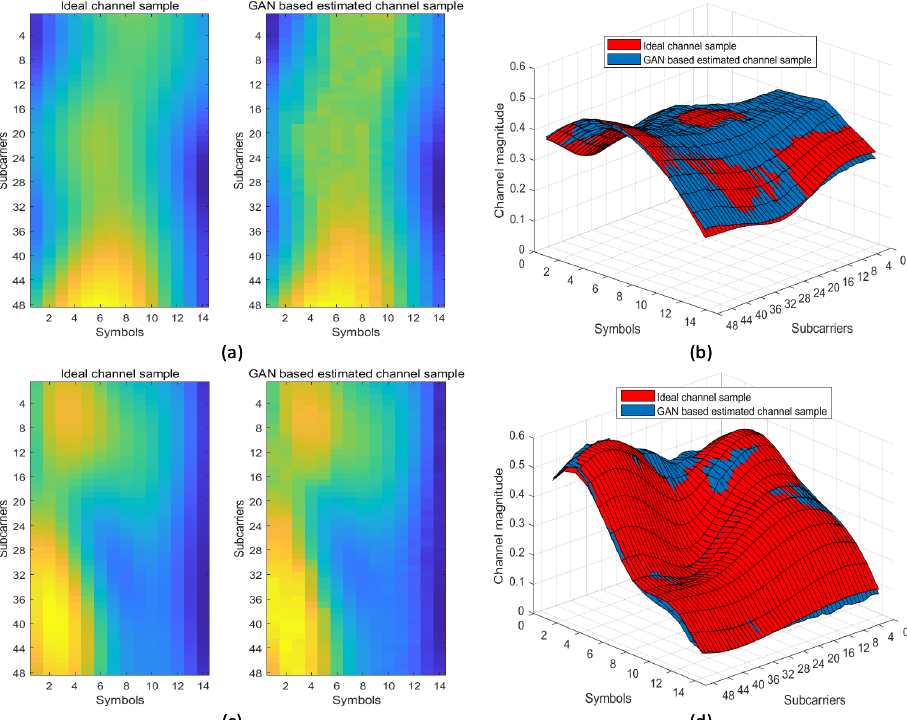
Figure 8. Comparison of GAN-based estimated channel samples and ideal channel samples (ground truth results) when SNR is set as 20 dB. In ( a , b ), the speed of terminal user is set as 150 km/h, while that in ( c , d ) is set as 300 km/h. Moreover, ( a , c ) show the channel magnitude from a two-dimensional perspective, while ( b , d ) show that from a three-dimensional